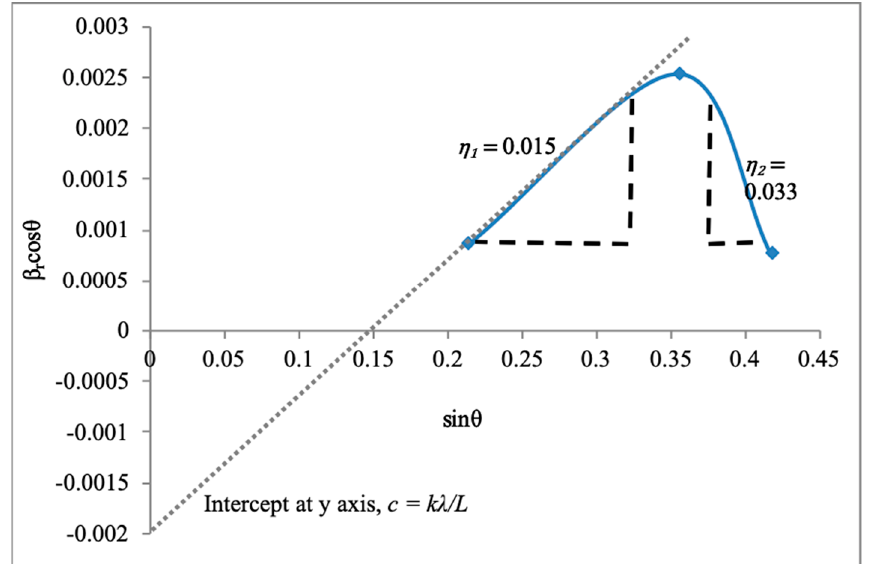
Figure 10. Plot of β r cos θ versus sin θ from XRD data of the 46 min sample.